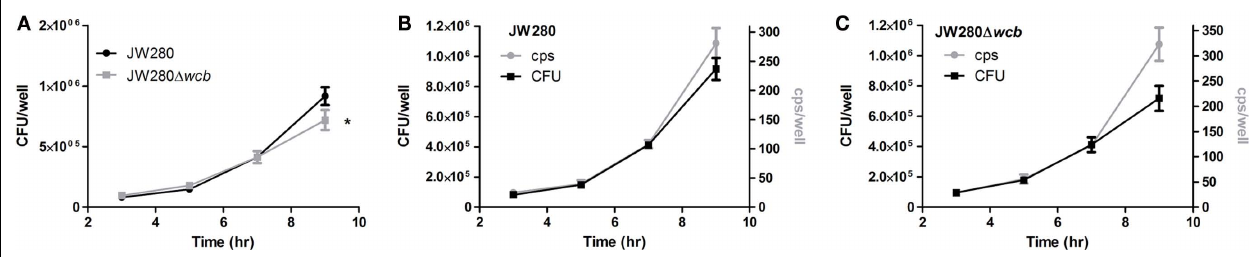
FIGURE 1 | Intracellular survival of B. pseudomallei in J774A.1 cell line. B. pseudomallei strains JW280 and JW280 (cid:2) wcb were used to infect 7.5 × 10 4 J774A.1 murine macrophages in triplicate at an MOI of 0.5. After 1h, extracellular bacteria were killed with gentamicin. At time points of 3, 5, 7,